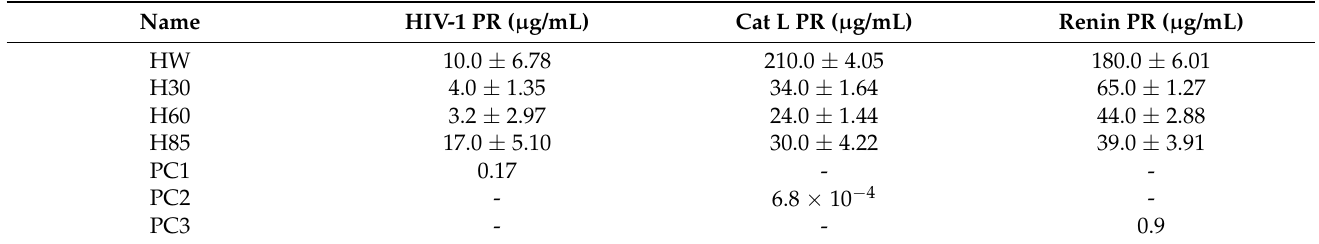
Table 1. The IC 50 values of H. kouytchense insect gall extracts against HIV-1, Cat L and renin PRs ( n = 3).